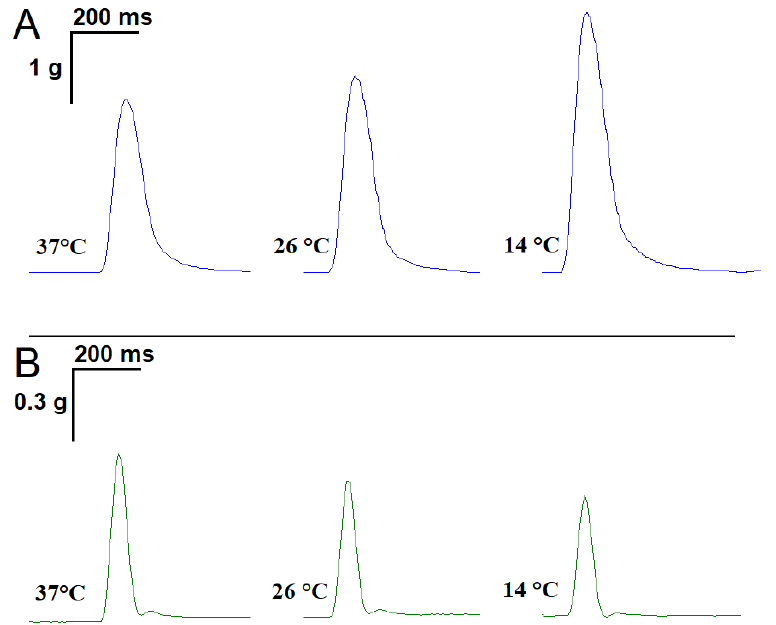
Figure 1. Records of single contractile responses of rat m. soleus ( A ) and m. EDL ( B ) induced by electrical field stimulation at different